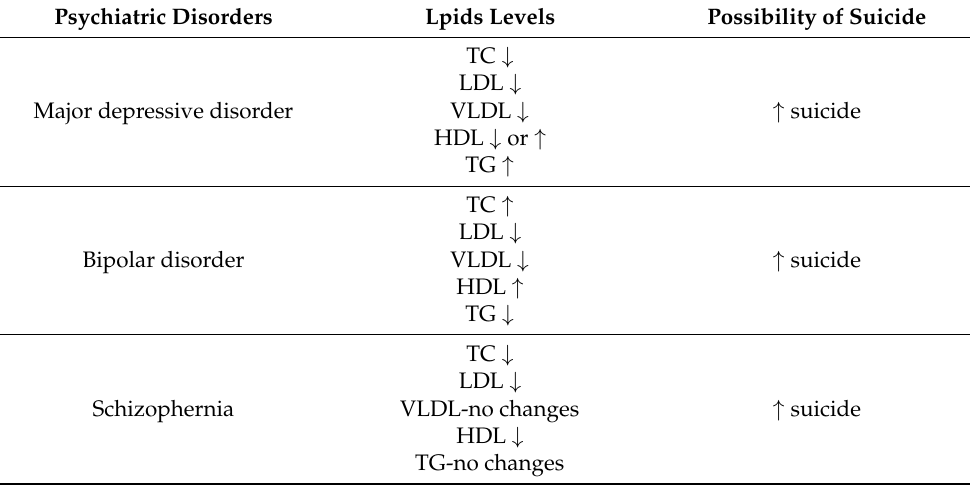
Table 1. Possible variants of changes in the level of lipids in depression, bipolar disorder and schizophrenia. Psychiatric Disorders Lpids Levels Possibility of Suicide